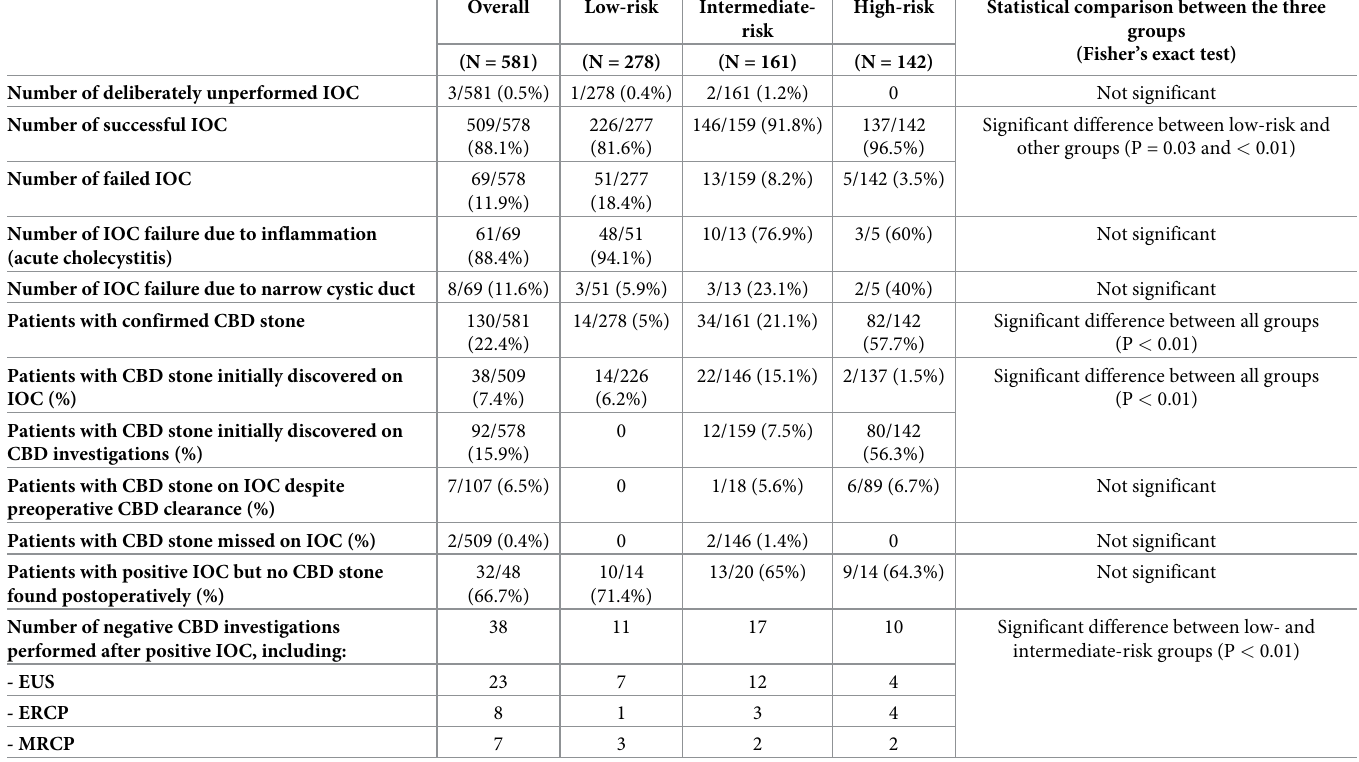
Table 2. Primary and secondary